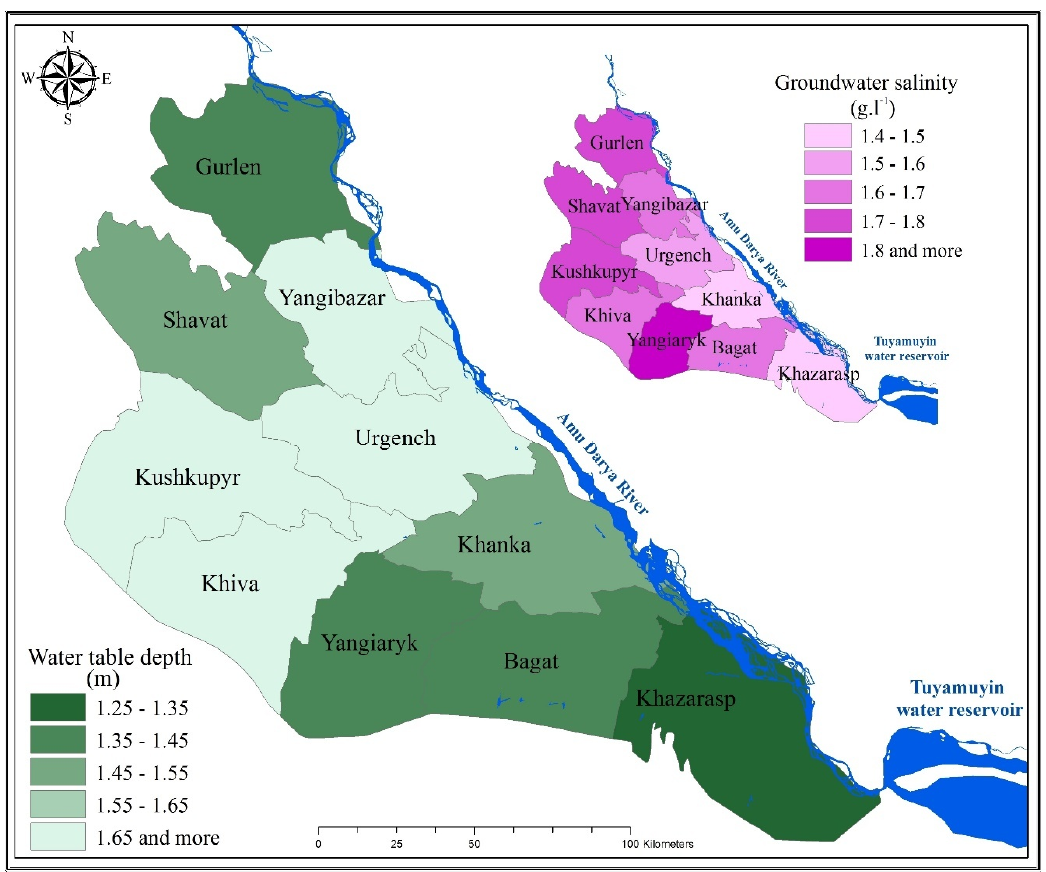
Figure 3. Water table depths and salinity in the Khorezm region during 1991–2017.